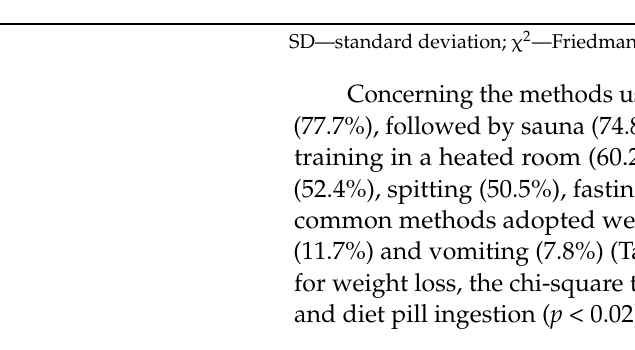
Table 3. Frequency distribution for weight loss methods reported by two categories of sambo